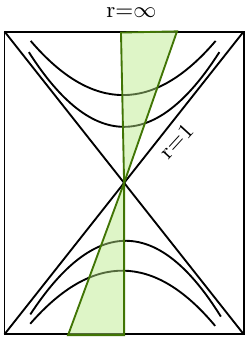
Figure 3 . The Milne patch where the orbifold identification is made. The green coloured region corresponds to the orbifold